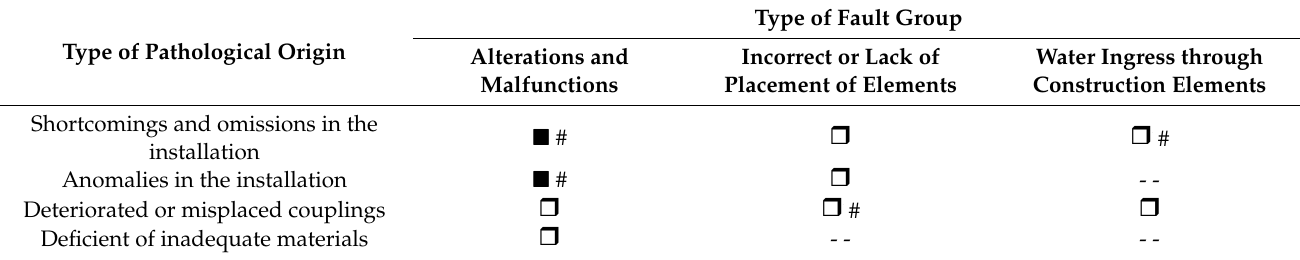
Table 2. Conceptual interrelation matrix between types of faults and pathological origins.